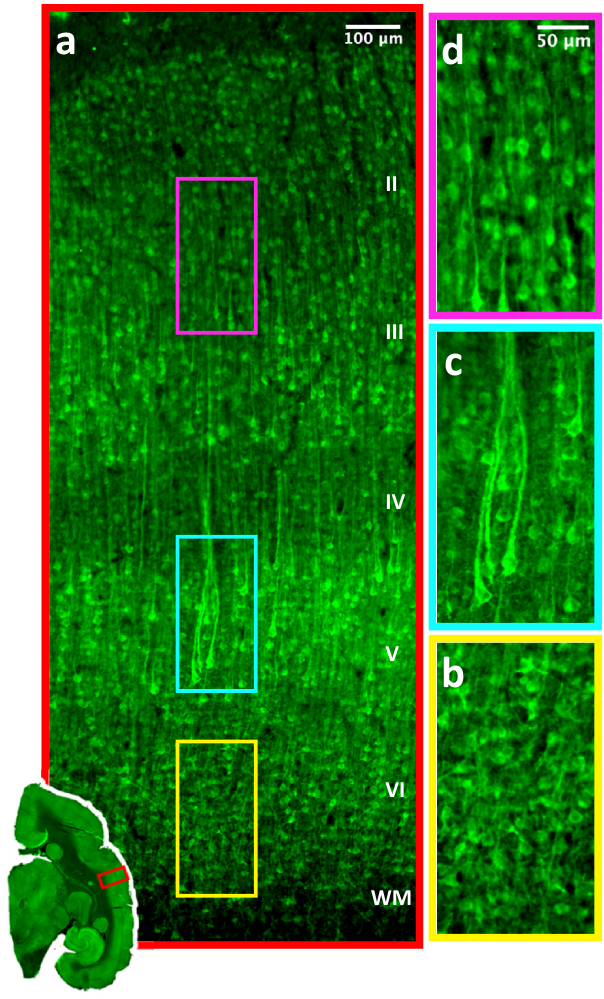
Fig. 6 | MAP-2 immunohostochemistry labeled tissue data qualitatively mat- ches the pro fi les of dMRI-FA and Nissl-HA. a The stain reveals the larger apical dendrites and associated pyramidal cell bodies. b In layer 6 cell body orientations and dendrites are smaller and incoherently organized. c Layer 5 pyramidal cell bodies are larger, orientated vertically and project large vertical dendrites which bundle as they proceed into layer 4. d Cell bodies in layers 3 and 2 are smaller and apical dendrites less visble. MAP-2 staining carried out in one animal, these struc- tures were representative of the n sections we stained. We examined 6 such sec- tions which showed similar